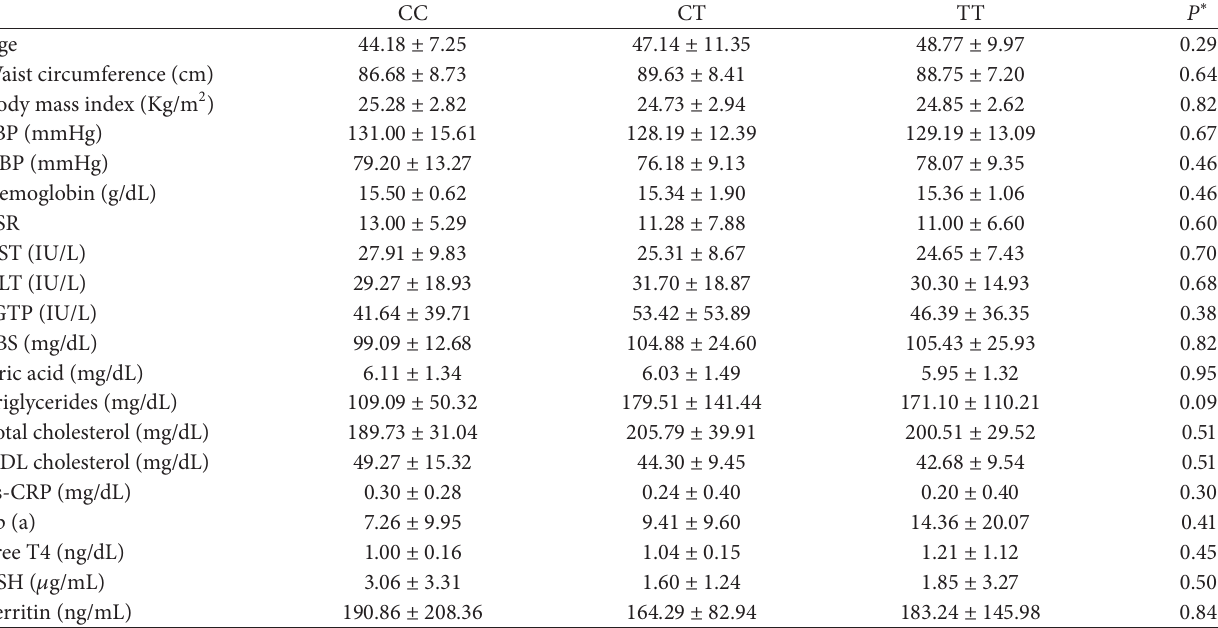
Table 2: Risk factors for atherosclerosis according to male gender. CC CT P